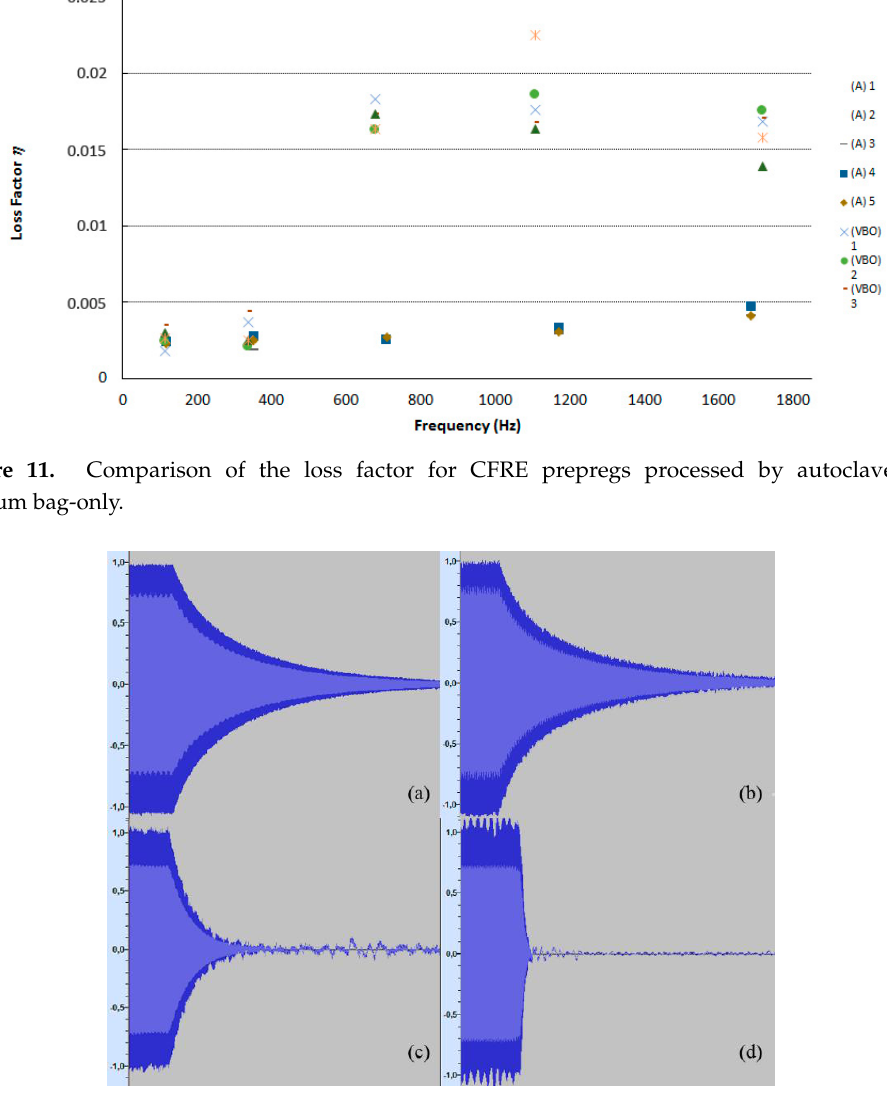
Figure 12. Transient analysis of CFRE plates: ( a ) Autoclave 2.0 vibrational mode; ( b ) vacuum bag-only 2.0 vibrational mode; ( c ) autoclave 5.0 vibrational mode; and ( d ) vacuum bag-only 5.0 vibrational mode.